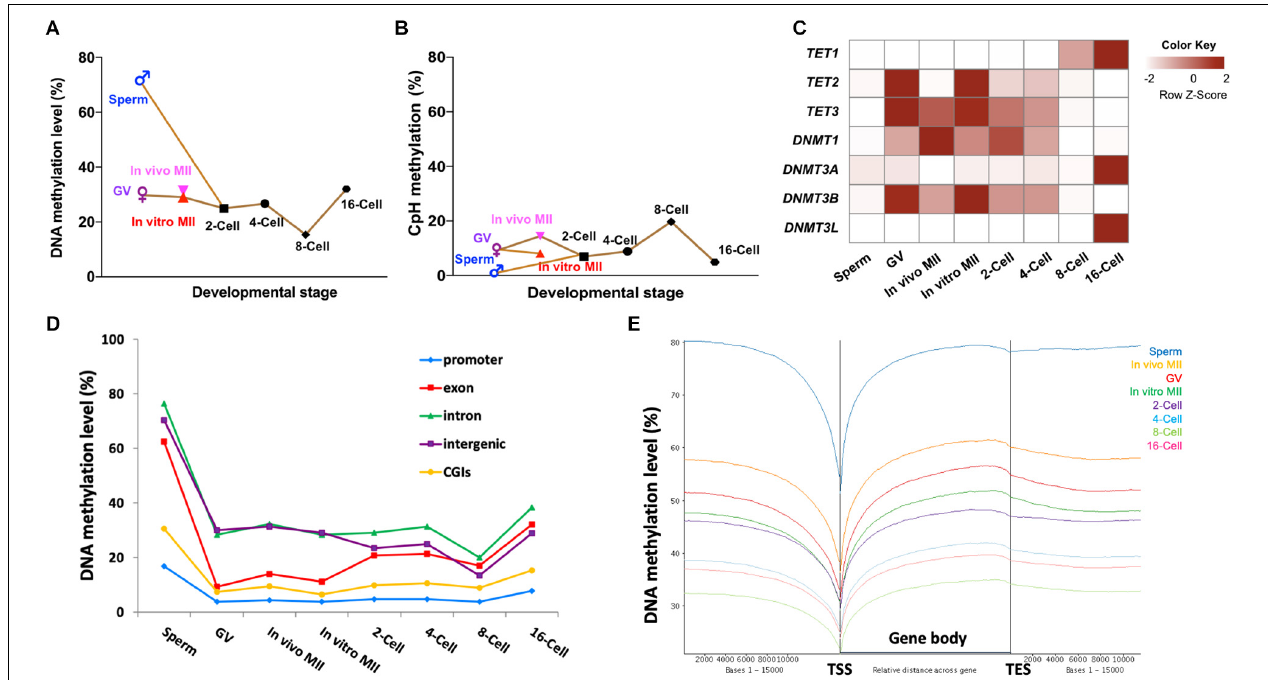
FIGURE 1 | Methylome dynamics during bovine pre-implantation embryonic development. Line chart of averaged levels of CpG (A) and CpH (B) methylation across stages. Heatmap (C) of fragment per kilobase million (FPKM) expressions of DNMT and TET gene families in bovine early embryos. Line chart (D) of the average DNA methylation levels of annotated genomic features across stages. Trend plot (E) of averaged DNA methylation levels along the gene bodies [from transcription start sites (TSS) to transcription end sites (TES)] and 15,000 base pairs (bp) up- and down-stream of the gene body. GV, germinal vesicle oocytes; MII, matured oocytes.